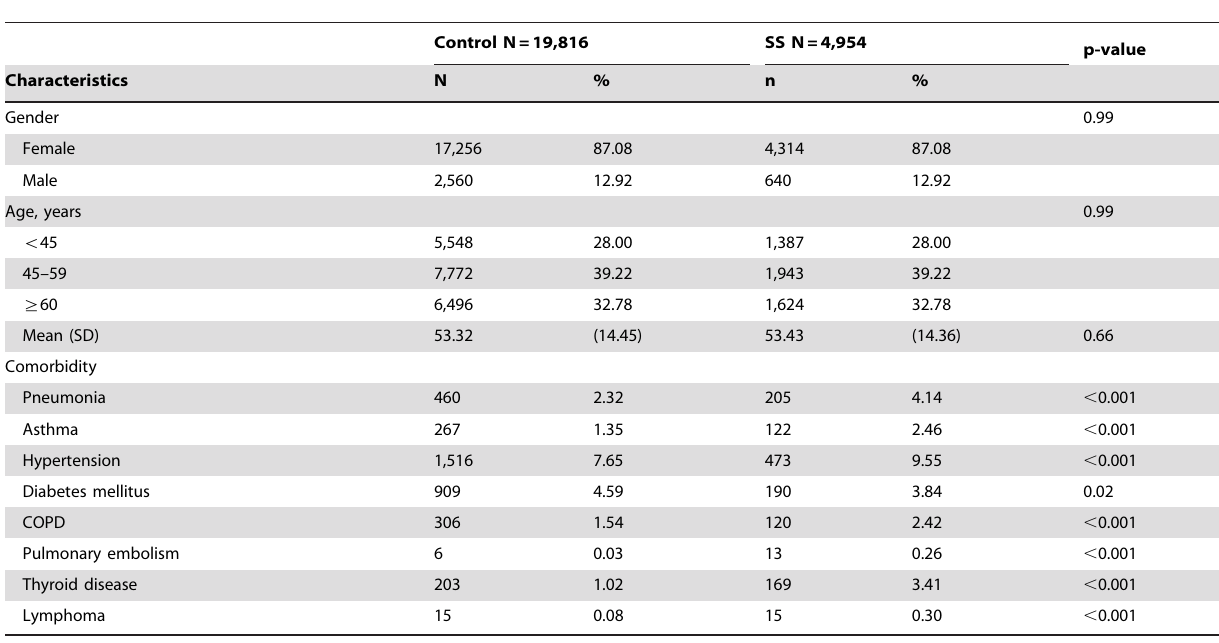
Table 1. Baseline demographic factors and comorbidity of study participants according to sjogren’s syndrome status.